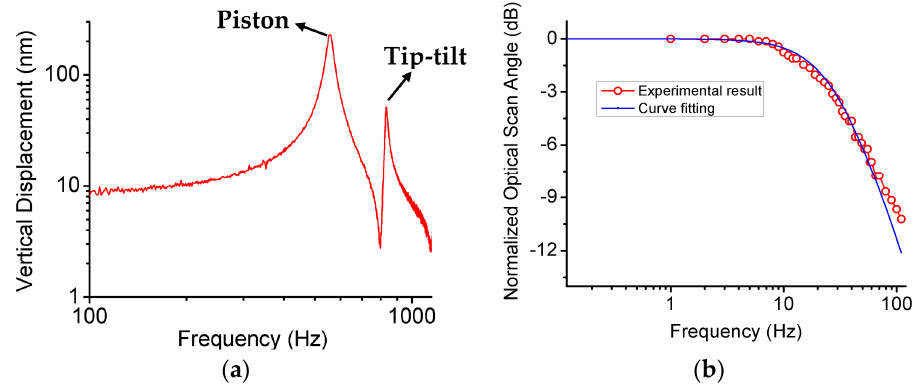
Figure 10. ( a ) Frequency response of the vertical displacement from 100 to 2000 Hz; ( b ) Frequency response of the scan angle from 0.1 to 100 Hz, the experimental result is fitted using first-order low-pass RC circuit, time constant τ = RC = 5.65 ms .